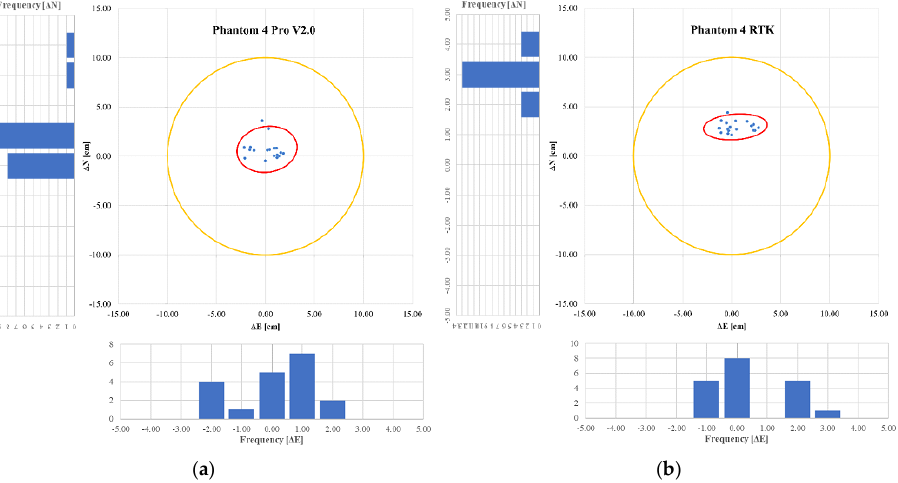
Figure 7. Confidence ellipse — Phantom 4 Pro V2.0 with GCPs at 60 m ( a ); Confidence ellipse — Phan- tom 4 RTK without GCPs (RTK) at 60 m ( b ).